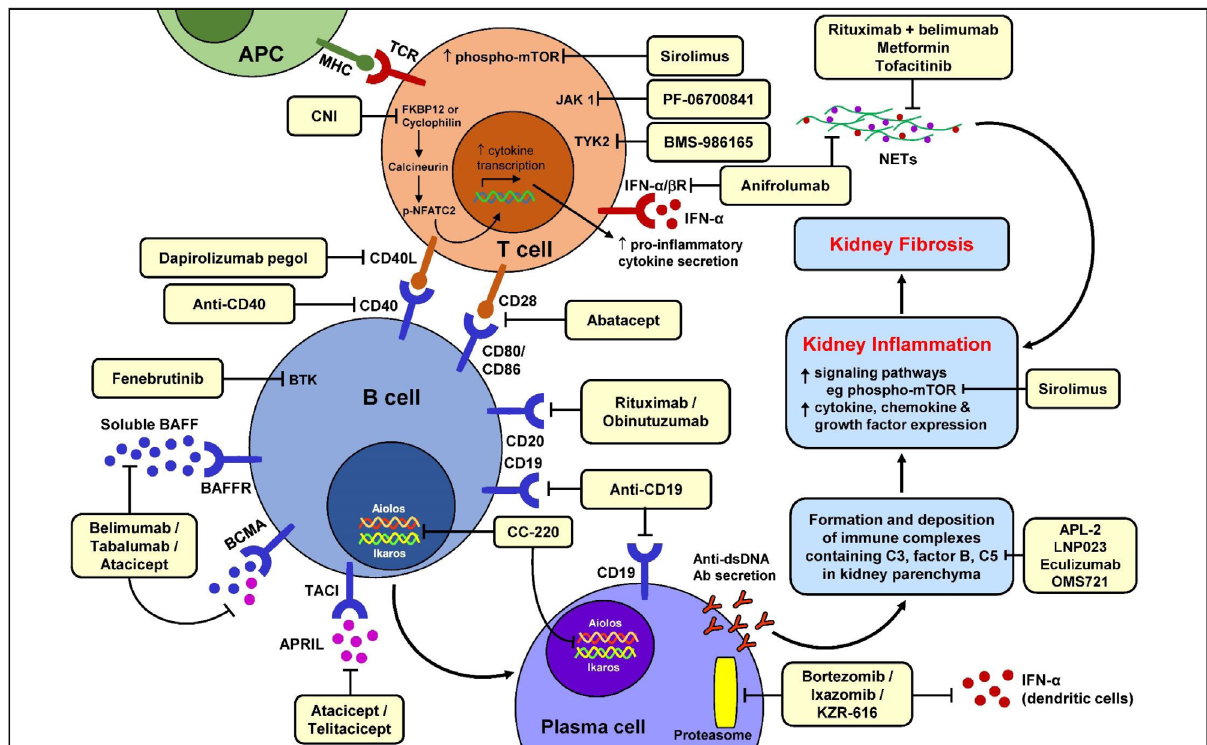
Figure 1. Schematic diagram showing the immunopathogenic pathways leading to kidney damage in lupus nephritis and emerging novel therapies targeting specific pathways. Ab, antibody; APC, antigen presenting cell; APRIL, a proliferating-inducing ligand; BAFF, B cell activating factor; BAFFR, B cell activating factor receptor; BCMA, B cell maturation antigen; BTK, Bruton’s tyrosine kinase; C3, complement 3; C5, complement 5; CD, cluster of differentiation; CNI, calcineurin inhibitor; ds, double-stranded; FKBP12, FK506-binding protein; IFN, interferon; IFN α / β R, interferon- α / β receptor; JAK, Janus kinase; MHC, major histocompatibility complex; mTOR, mammalian or mechanistic target of rapamycin; NETs, neutrophil extracellular traps; NFATC2, nuclear factor of activated T cells 2; TACI, transmembrane activator and calcium modulator and cyclophilin ligand interactor; TCR, T cell receptor; TYK2, tyrosine